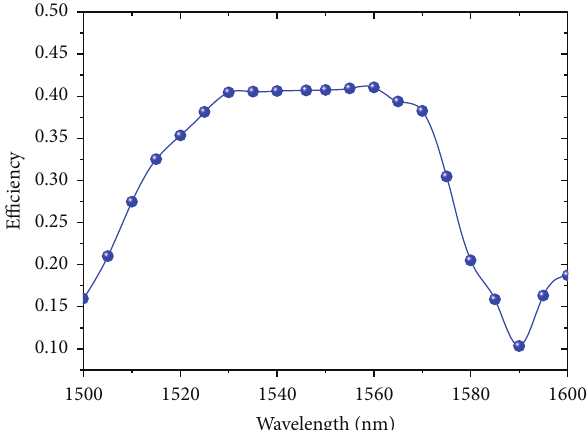
Figure 7: Wavelength and coupling efficiency at the incident angle of 0 ∘ .